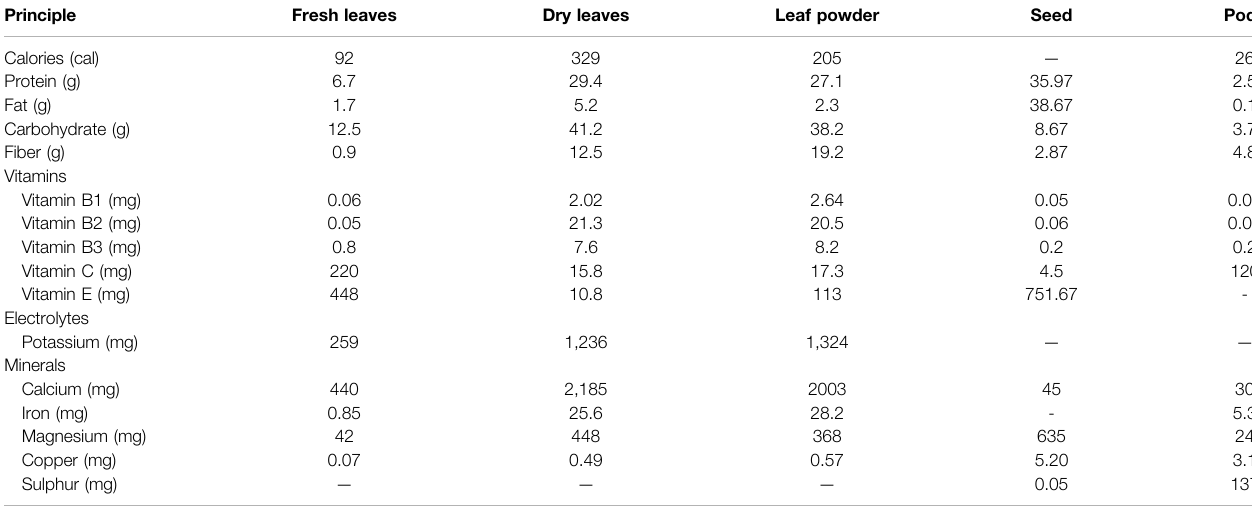
TABLE 1 | Nutrition composition of Moringa oleifera (value in 100 g of plant materials) (Olagbemide and Philip, 2014; Gopalakrishnan et al., 2016). Principle Fresh leaves Dry leaves